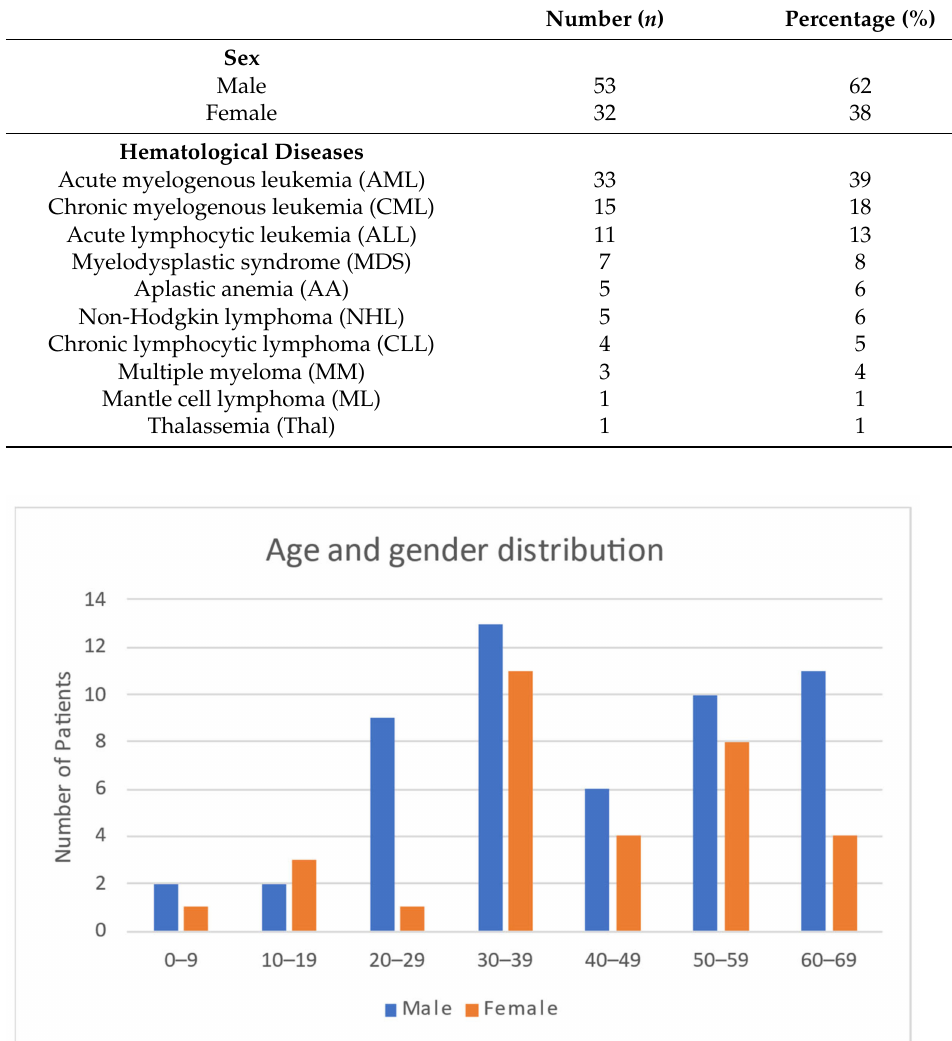
Figure 2. This figure represents gender and age distribution among the described